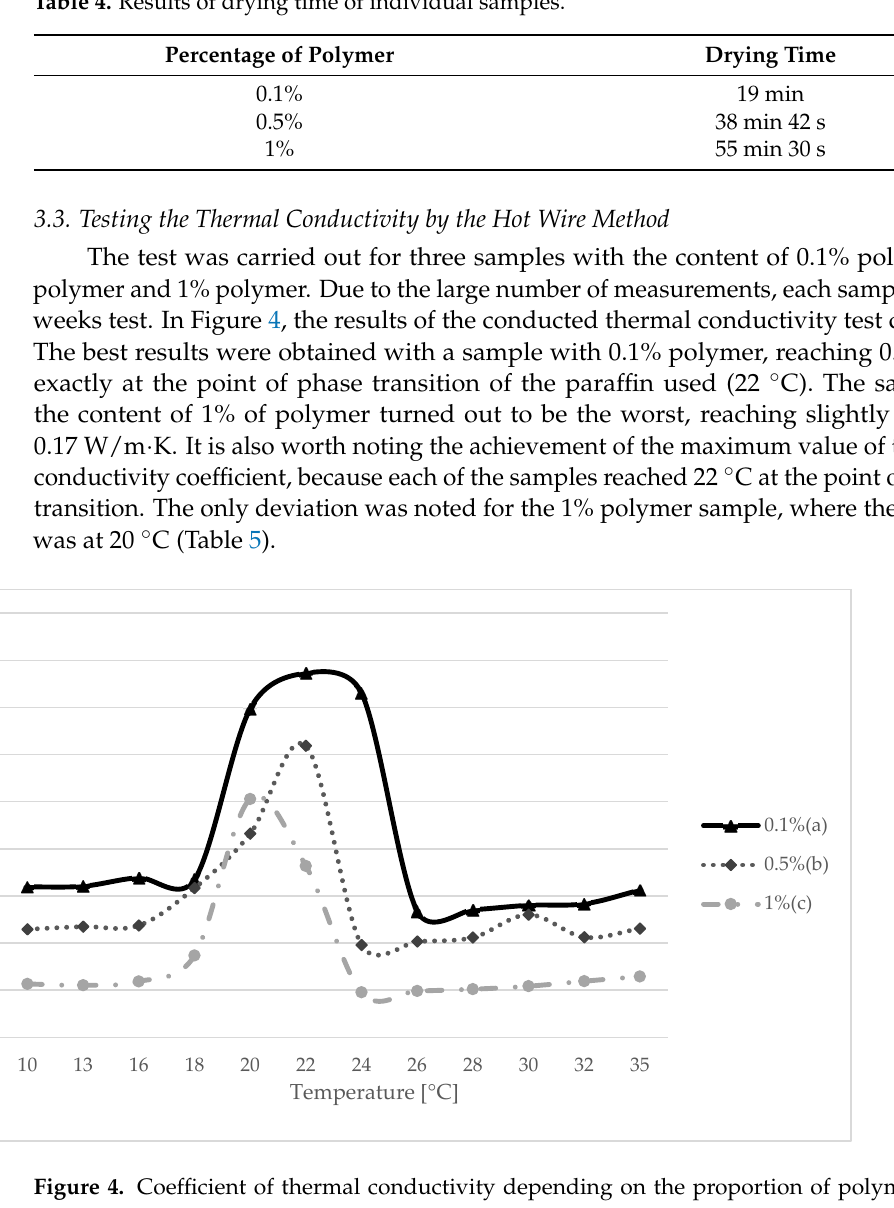
Table 4. Results of drying time of individual samples.